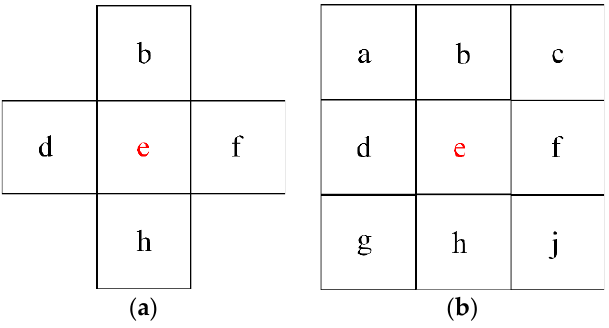
Figure 4. Neighbor type ( a ) Neumann, ( b )